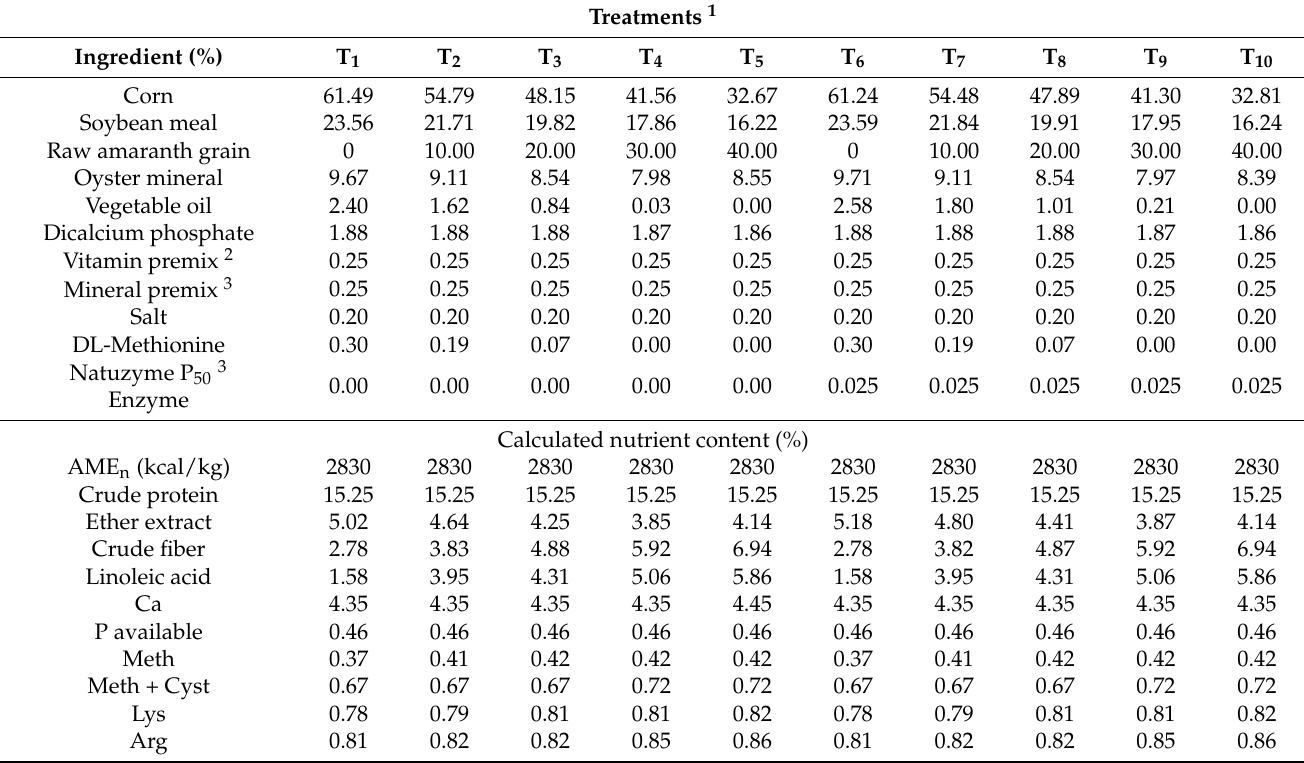
Table 2. Ingredients and chemical composition of the diets fed to laying